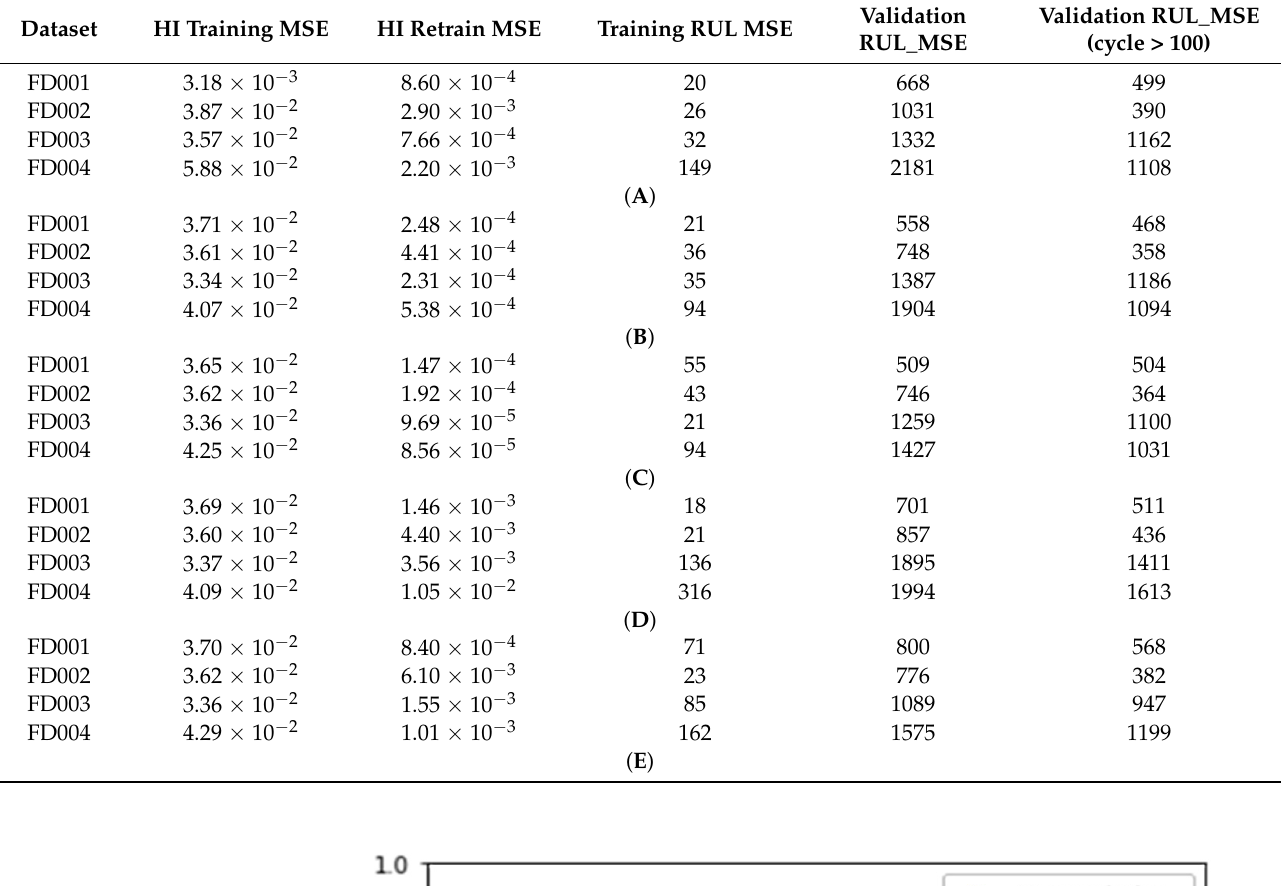
Table 5. ( A ) Linear Regression, ( B ) Linear Regression + PCA, ( C ) MLP + PCA, ( D ) RF + PCA, ( E ) SVR + PCA; HI Training MSE stands for the MSE of the partial data training; HI Retrain MSE stands for the MSE of the retrain on the whole dataset; Training RUL MSE represents the evaluation of RUL with the training data; Validation RUL MSE represents the validation result of RUL estimation of the test data; Validation RUL MSE represents the validation of RUL in test data with cycle > 100.